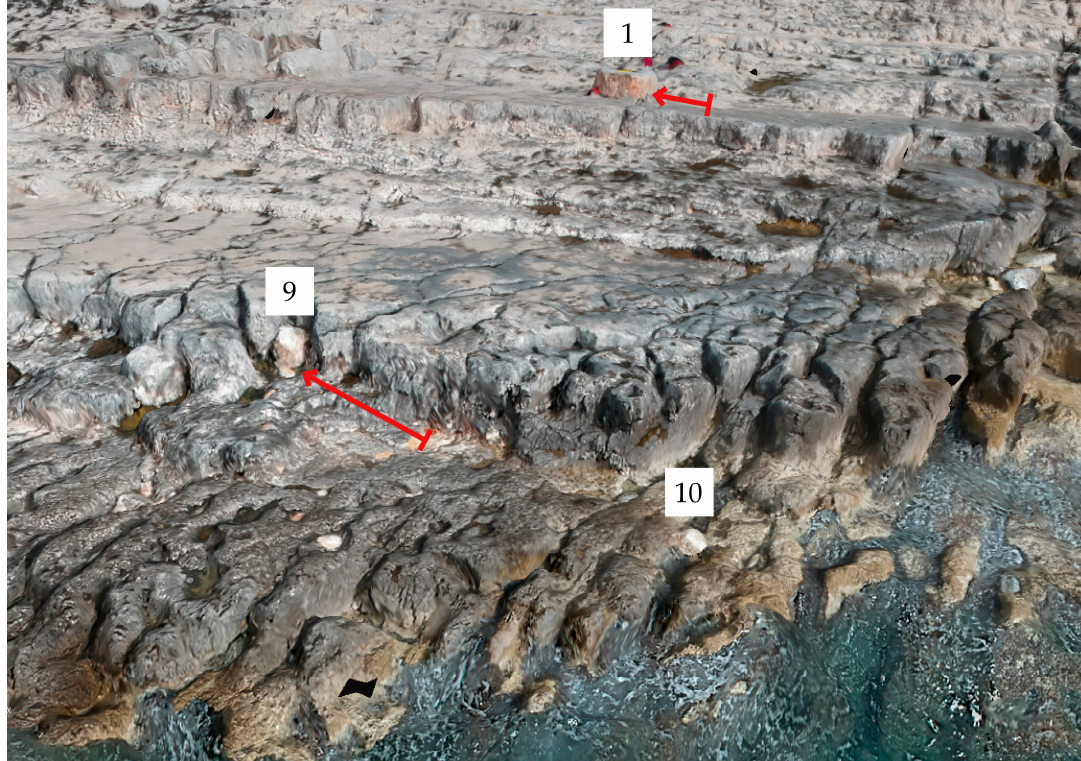
Figure 5. A view of the three-dimensional (3D) model obtained during Flight #2 performed on 30 April 2019. The red arrows show the shift of boulders #1 and #9 and the position of the new boulder #10.